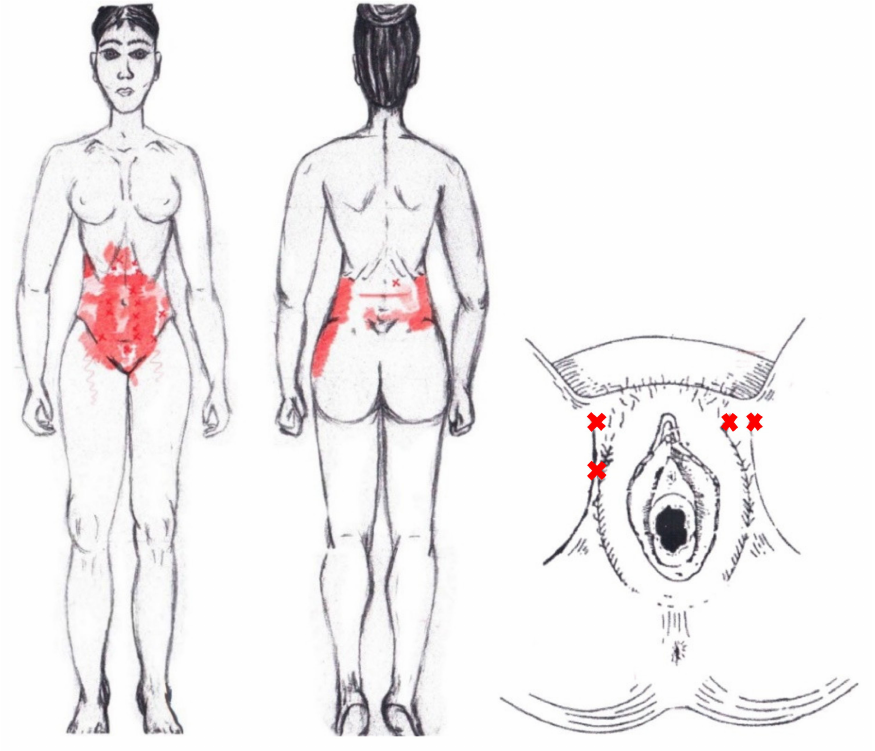
Figure 4. Graphical simulation of referred pain areas of the rectus abdominis muscle. The frequency at the areas of referred rectus abdominis muscle pain in the menstrual phase and in the ovulatory phase is shown in Tables 9 and 10,